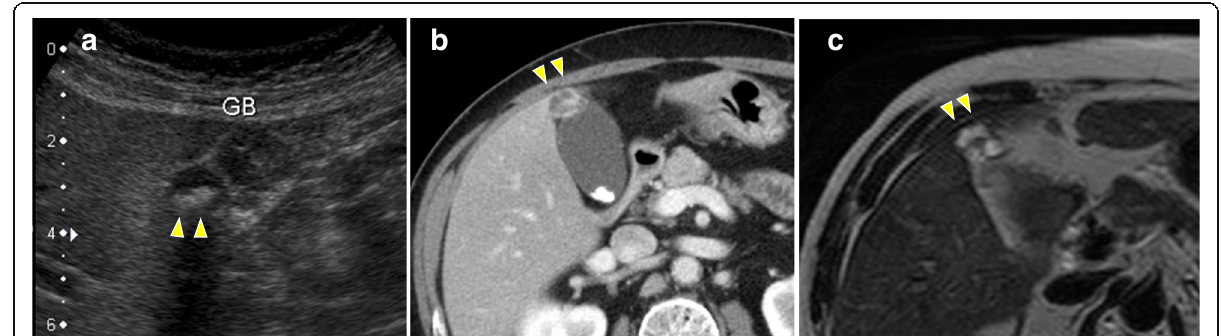
Fig. 1 Preoperative imaging findings. a Abdominal ultrasonography showed an 8 × 7-mm solid mass at the gallbladder fundus. b Enhanced CT showed that irregular wall thickening at the gallbladder fundus, and the boundary between the tumor and liver was indistinct. c T2-weighted MRI showed high-intensity nodules inside the thickened wall of the gallbladder